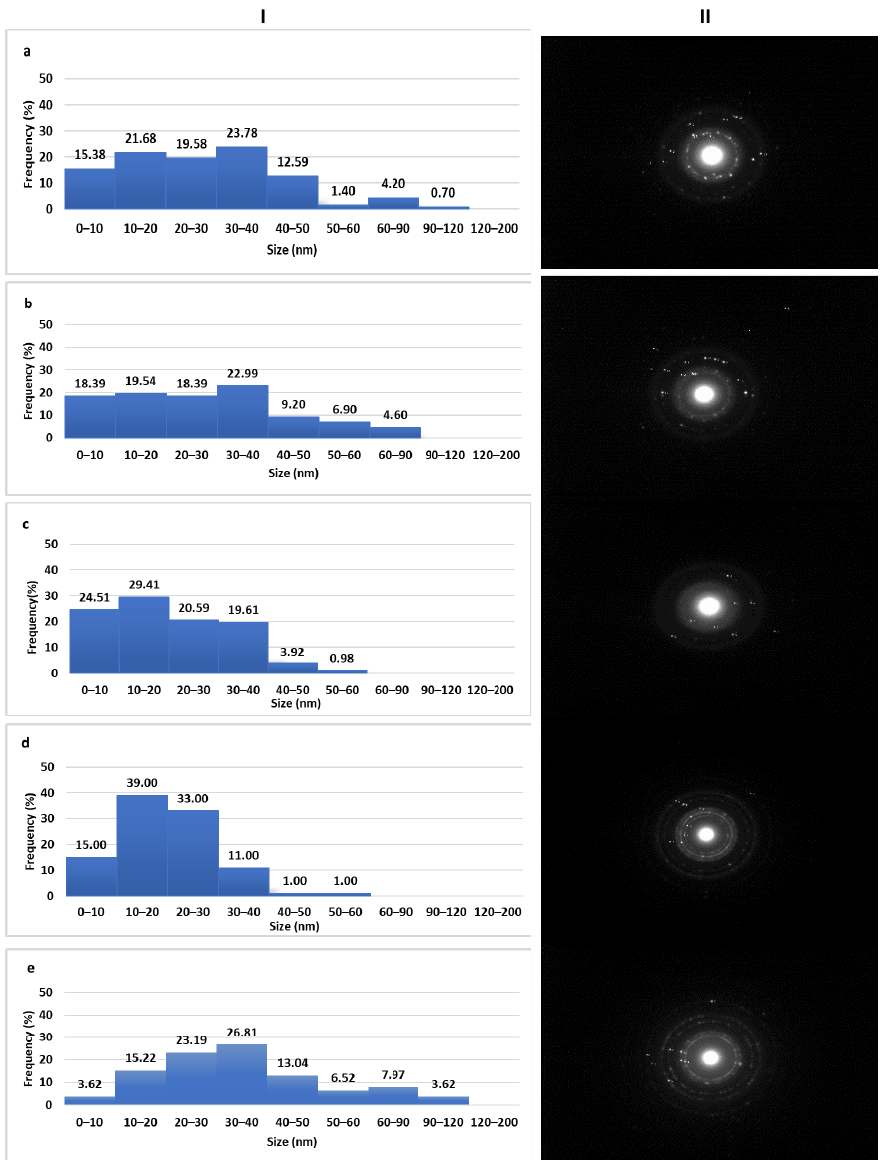
Figure 2. Size distribution obtained by TEM image analysis ( I ) and selected area (electron) diffraction (SAED) patterns ( II ) of dittany ( a ), sage ( b ), sea buckthorn ( c ), calendula ( d ), and NaBH 4 AgNPs ( e ).